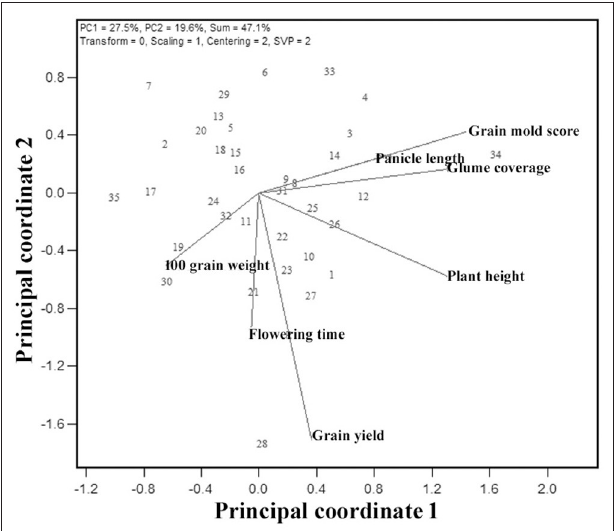
FIGURE 7 | Genotype-trait (GT) biplot indicating interrelationships among the measured traits from 35 sorghum genotypes.